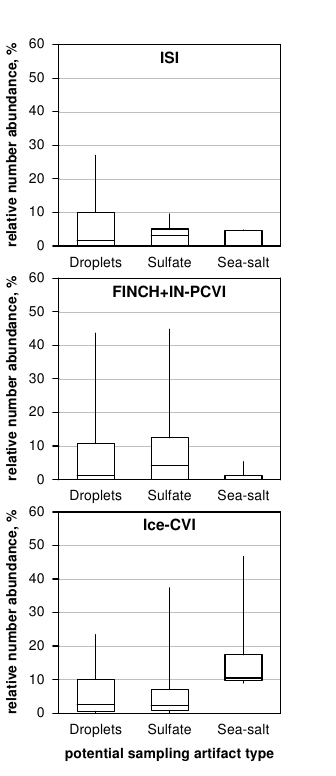
Figure 7. Box plots of impacted droplets, (non-droplet) sulfate and sea-salt abundance for ISI, FINCH + IN-PCVI and Ice-CVI. Shown are the minimum, lower quartile, median, upper quartile, and maxi- mum. Figure 8. Average of all single sample size distributions of major